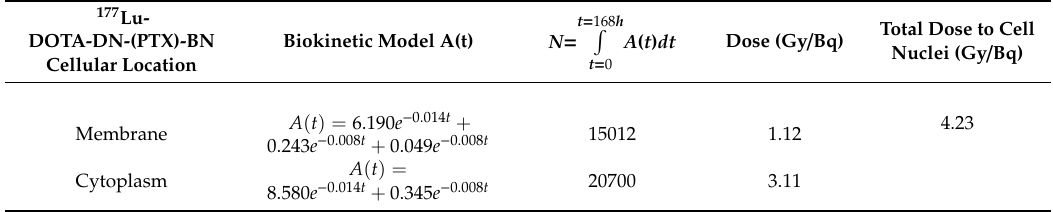
Biokinetic model and radiation absorbed doses produced by Bq / cell of 177 Lu- DOTA-DN-(PTX)-BN to the T47D cancer cell nuclei within 168